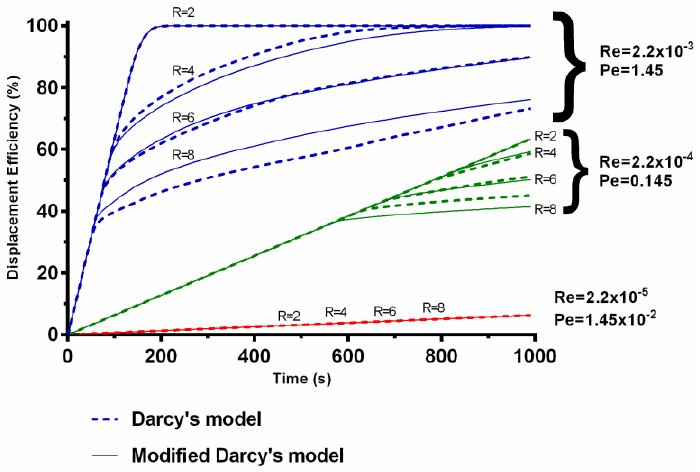
Figure 6. Comparison of displacement efficiency for fluids with different viscosity ratios, R , Reynolds number, Re , and Peclet number, Pe.